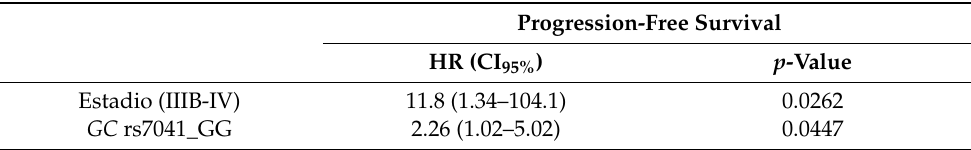
Figure 7. Kaplan–Meier plot of progression-free survival curves with the T allele of the GC rs7041 gene polymorphism in the resected NSCLC subgroup. Table 7. Influence of gene polymorphisms and clinical characteristic on progression-free survival of resected NSCLC patients.